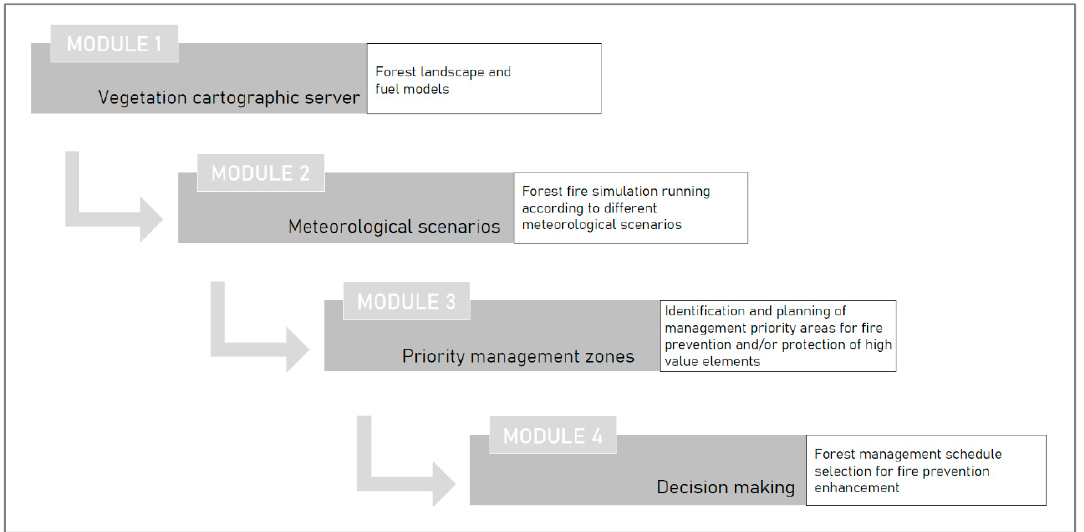
Figure 9. Theoretical organization of the PREVINCAT.cat server.